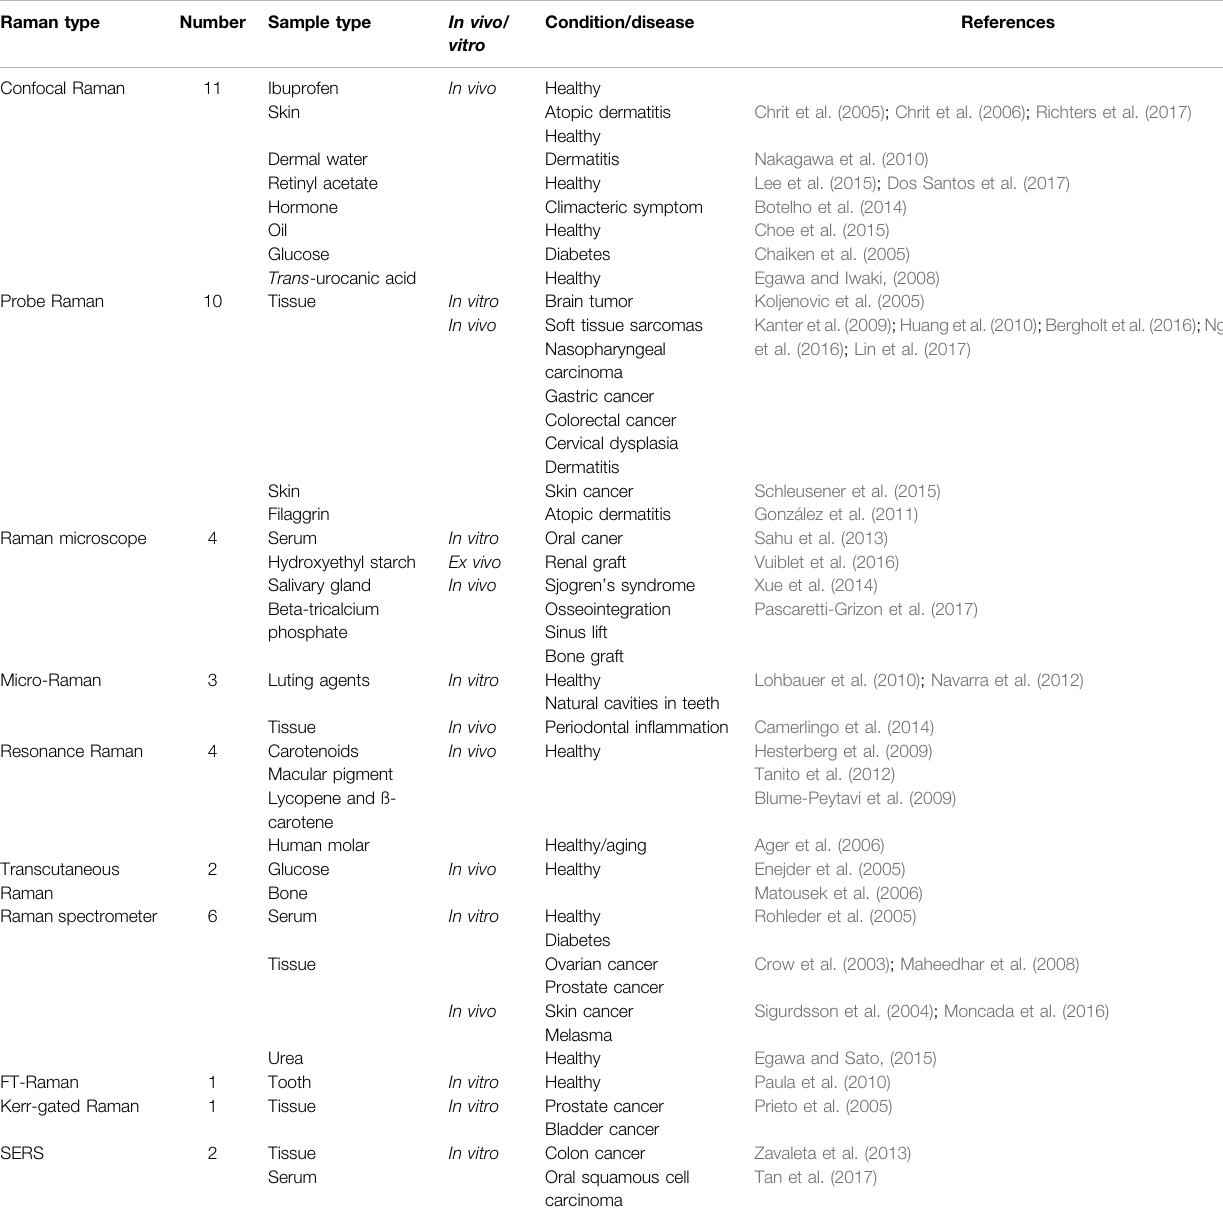
TABLE 2 | Characteristics of published Raman spectroscopy clinical